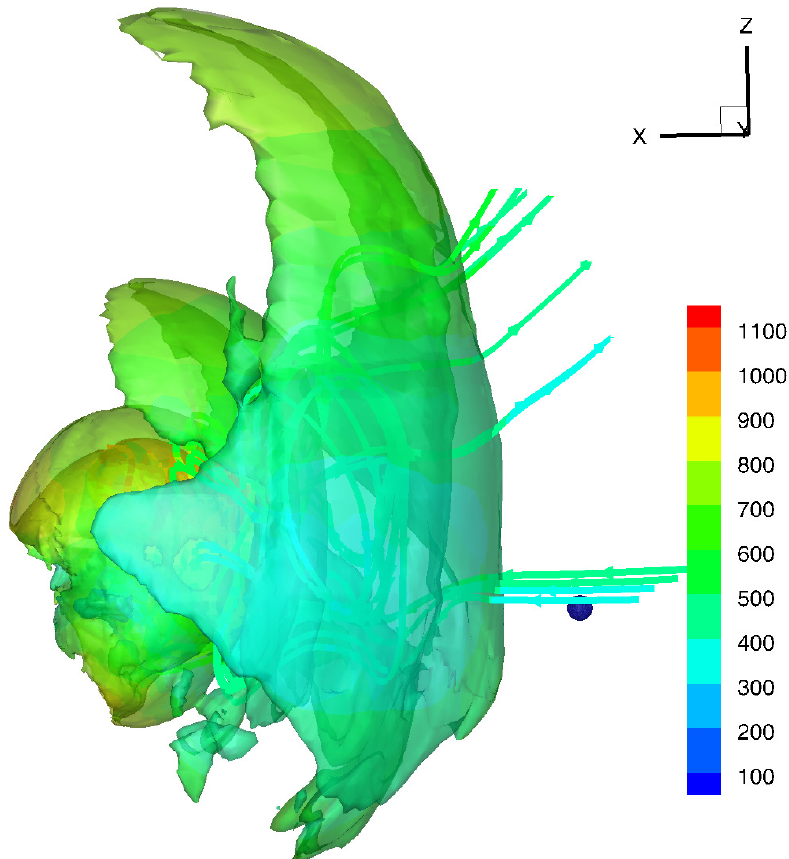
Figure 4. A 3D representation of the CME is shown at 50 h after the initiation of the first CME. The color code represents the velocity magnitude. Three-dimensional colored isosurfaces of ρ = 1.5 ρ wind are drawn. The blue sphere shows the position of the Earth with a radius of 5 R s